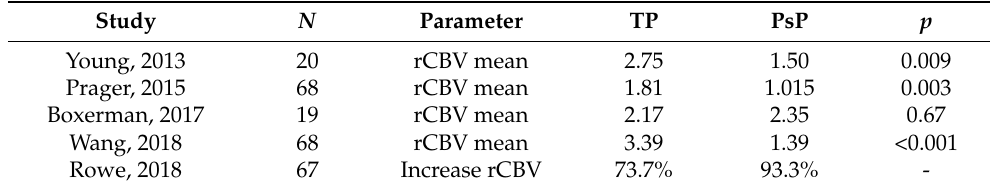
Table 2. Review of studies of DSC MRI. DSC = dynamic susceptibility contrast, MRI = magnetic resonance imaging, N = number of patients, TP = true progression, PsP = pseudoprogression, rCBV = relative cerebral blood volume. Study N Parameter TP